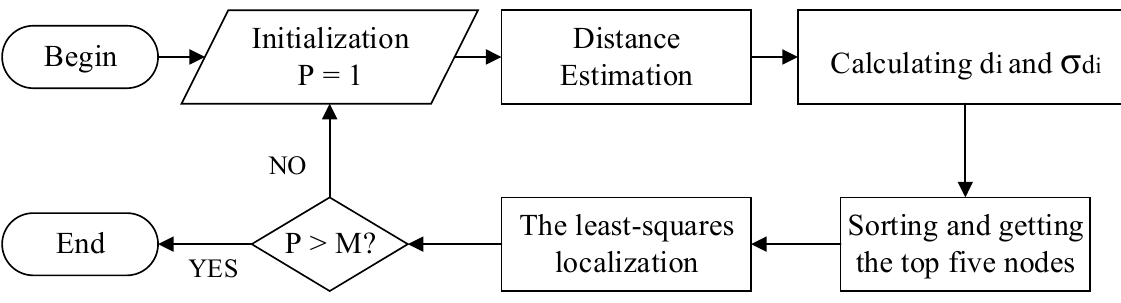
Figure 4. Procedures of the MSDO and MEPO localization method.